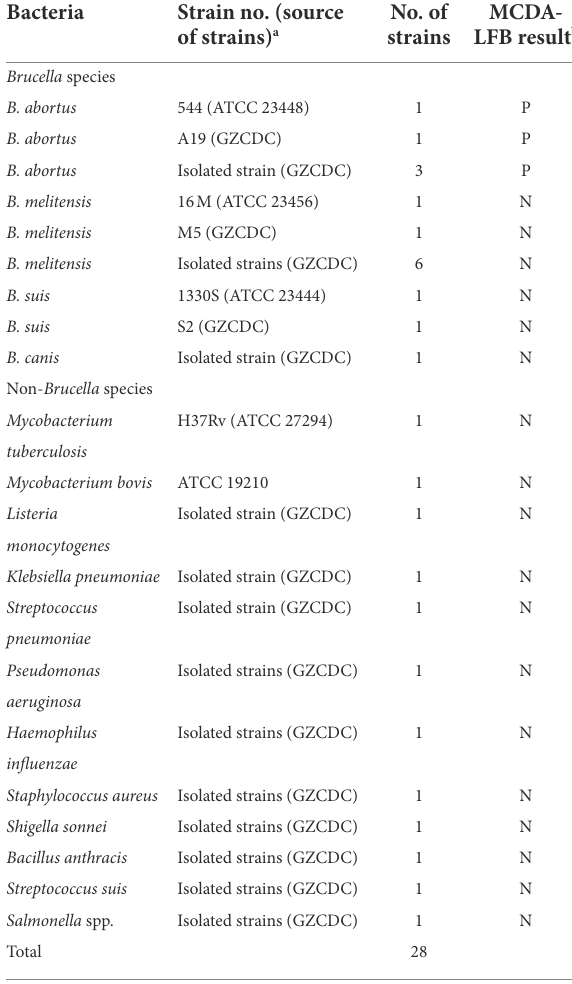
TABLE 2 The information of bacterial strains in this